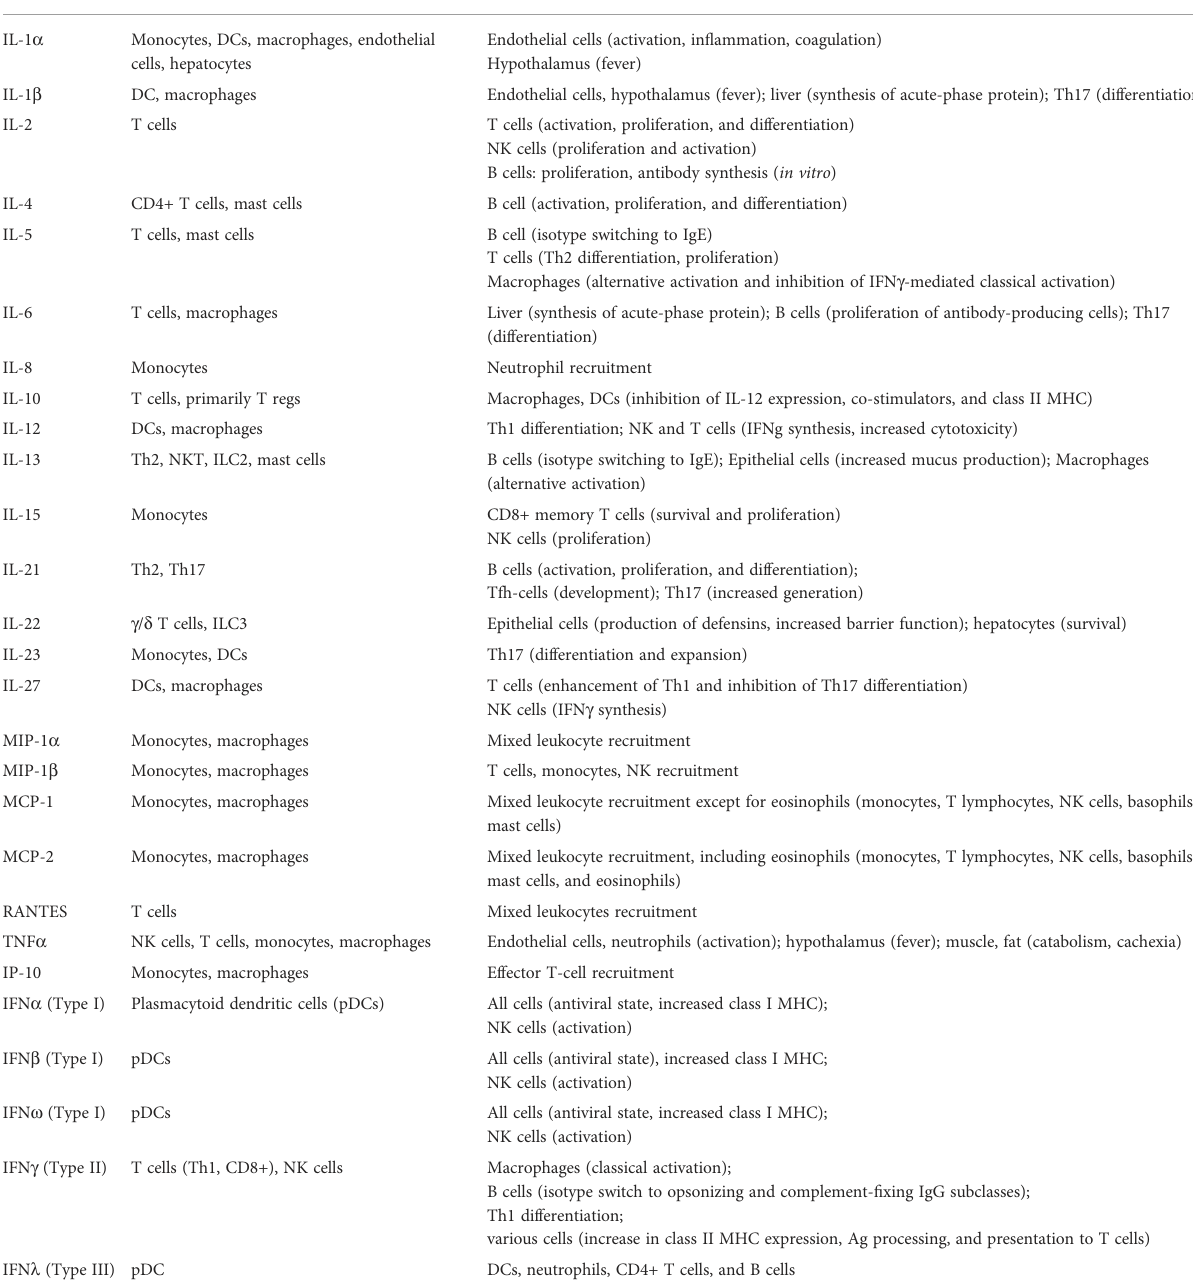
TABLE 1 Human cytokine panel used at NCL.